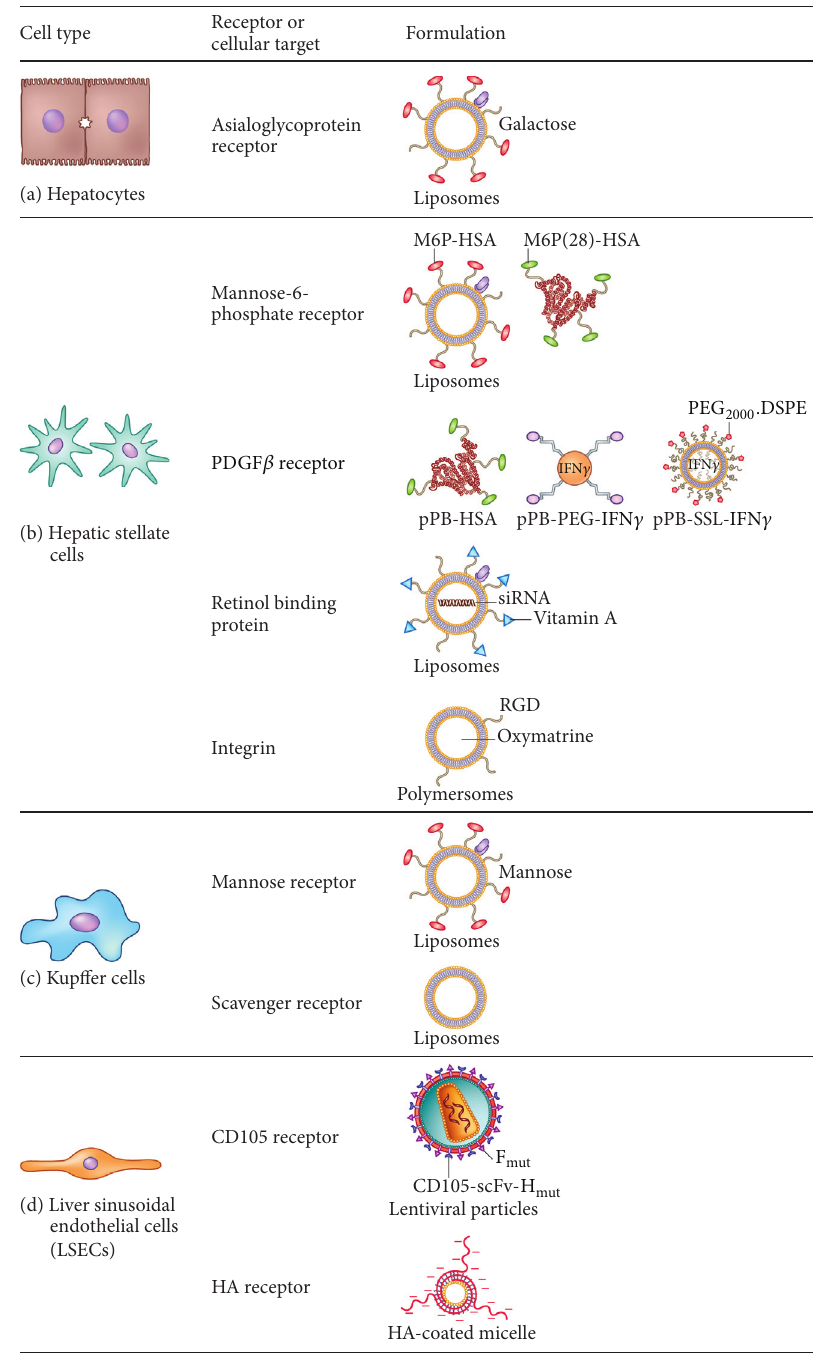
Figure 2: Receptors or cellular targets and different designed formulations for active targeting to the different cell types of liver. Nanoparticles or proteins are modified with specific surface ligands to be recognized by their receptors or cellular targets on a specific type of liver cells: (a) hepatocytes, (b) hepatic stellate cells (HSCs), (c) Kupffer cells (liver macrophages), and (d) liver sinusoidal endothelial